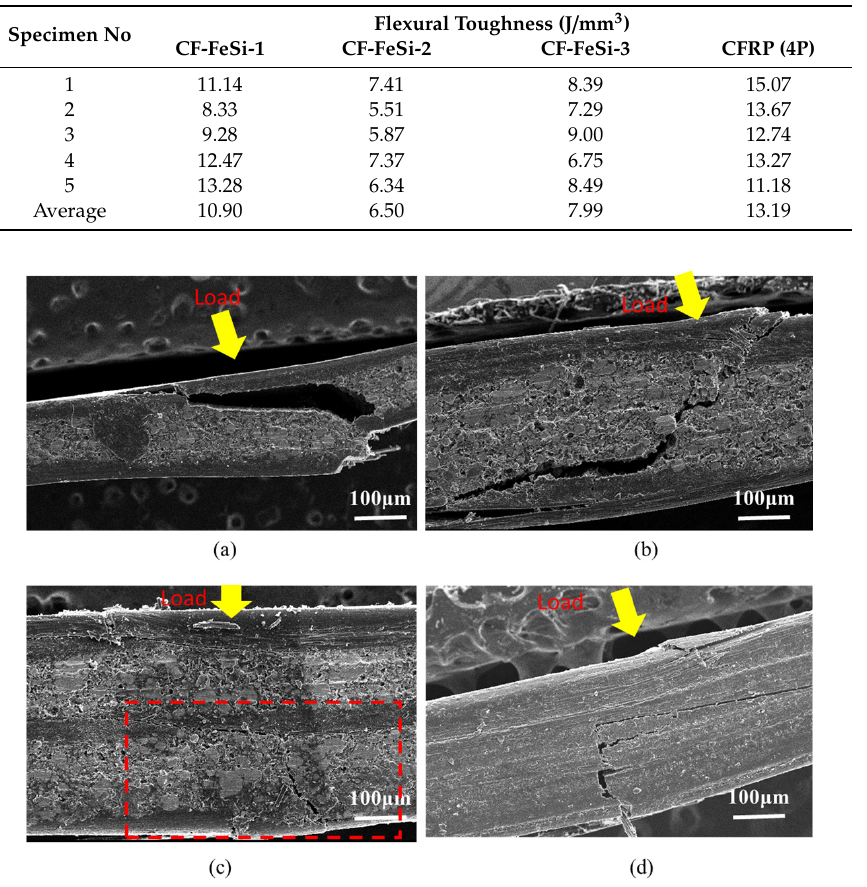
Figure 8. Fractography images of composites after bending test: ( a ) CF-FeSi-1; ( b ) CF-FeSi-2; ( c ) CF-FeSi-3; ( d ) CFRP(four-ply).